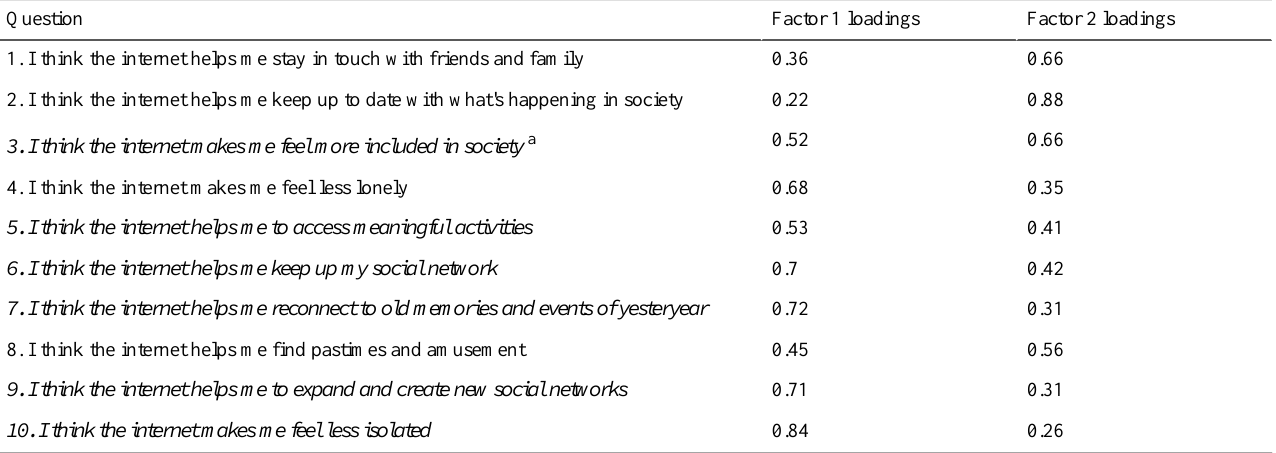
Table 2. Two-factor solution with (standardized) cross-loadings from exploratory factor analysis on the sampled group (n=193).